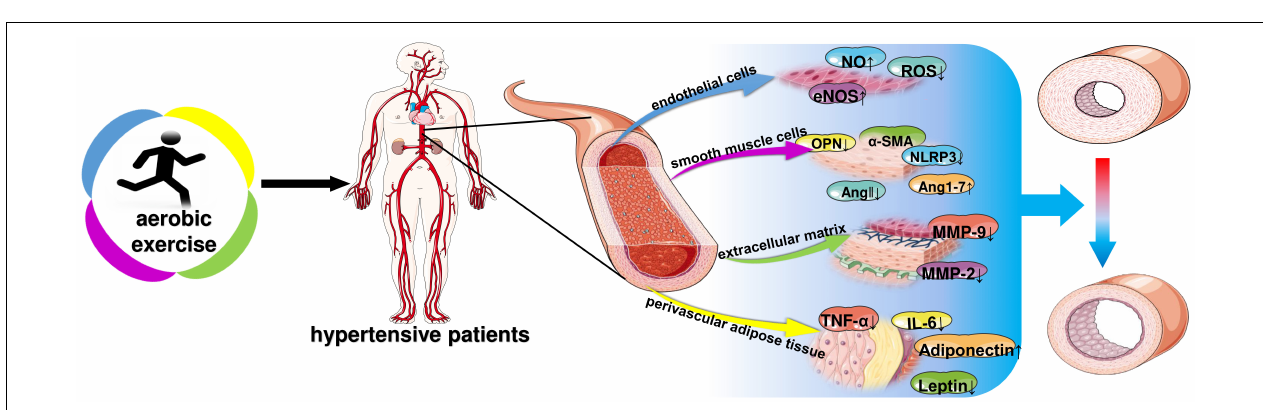
FIGURE 2 | Aerobic exercise improves molecular changes in vascular remodeling of hypertension. NO, nitric oxide; ROS, reactive oxygen species; eNOS, endothelial nitric oxide synthase; OPN, osteopontin; α -SMA, α -smooth muscle actin; NLRP3, NOD-like receptor thermal protein domain associated protein 3; ANG, angiotensin; MMP-9, matrix metallopeptidase 9; MMP-2, matrix metallopeptidase 2; IL-6, interleukin-6; TNF- α , tumor necrosis factor- α ; Adiponectin;